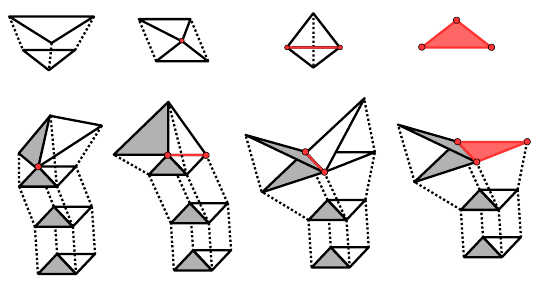
Figure 3. Triangle-polytope (top) spatial redundancies (red) and triangle-polytope complex (bottom) spatial redundancies